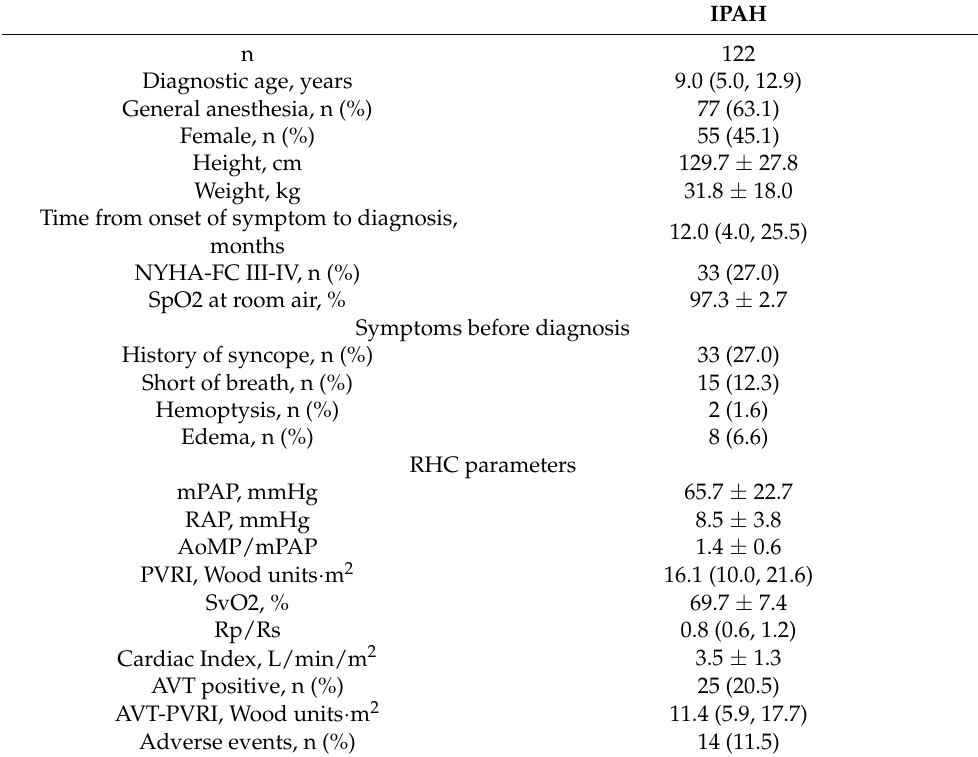
Table 2. Clinical characteristics and hemodynamics of patients with